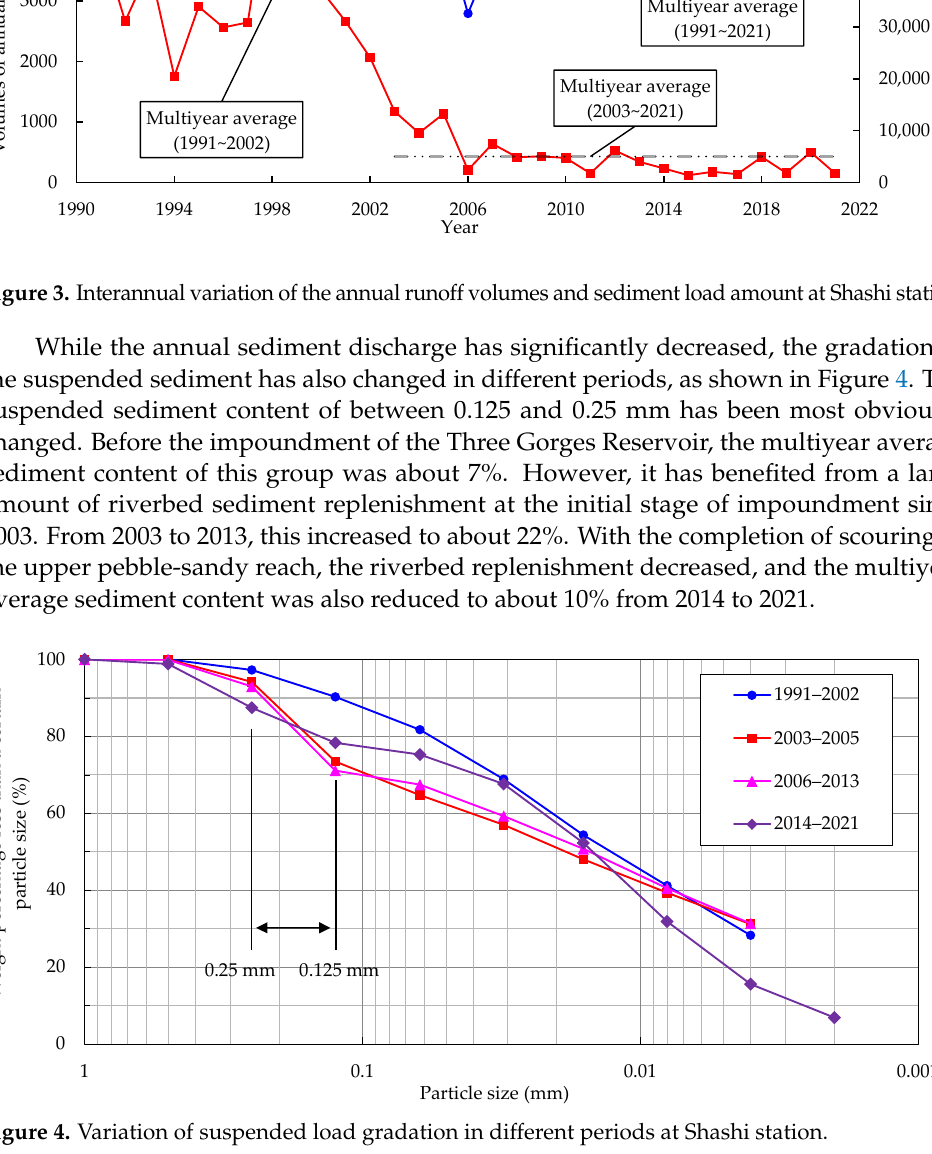
Figure 5. Annual change in characteristic particle size of the suspended load at Shashi station. 3.1.2. Monthly Distribution Figure 6a shows the distribution of runoff in different months within the year. It can be seen that the runoff is concentrated in July, August, and September, especially in July, both before and after the impoundment of the Three Gorges Reservoir. Taking the multi ‐ year average situation as an example, the runoff from July to September accounts for 44.6% of the whole year, and that in July accounts for 16.9%, with a coefficient of variation of 0.55.